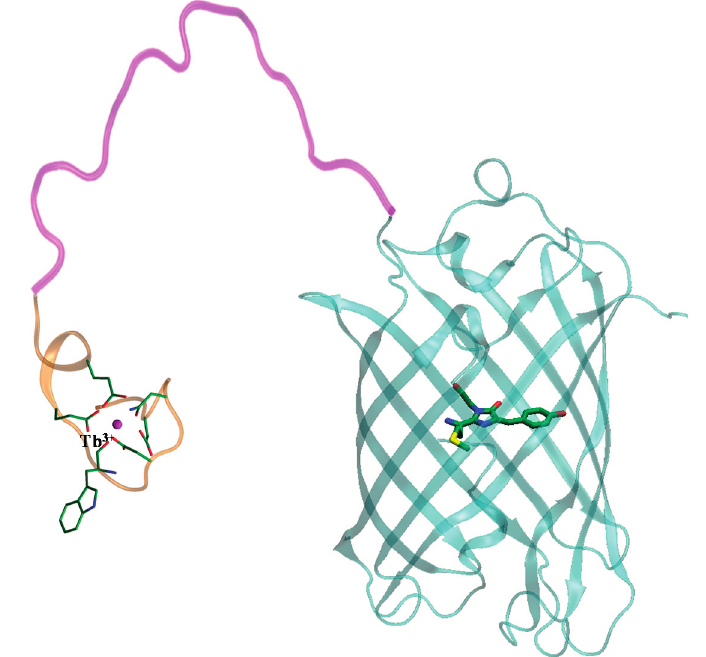
Figure 1. Structure of Tb 3+ -TBP-19-TagRFP sensor. Carbon atoms are shown in green, nitrogen atoms are shown in blue, and sulphur atom is shown in